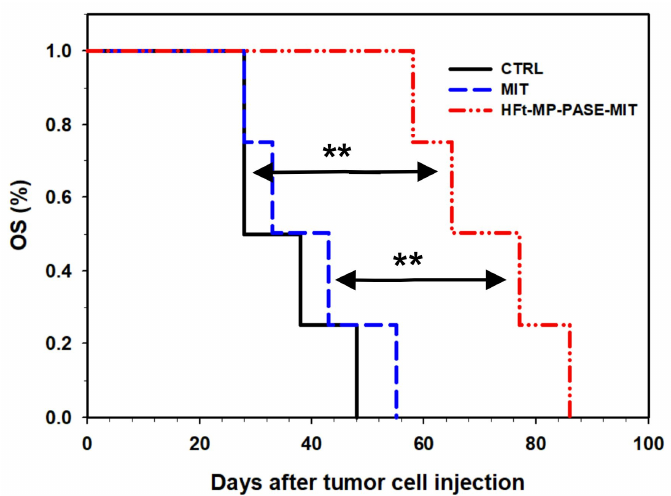
Figure 4. Kaplan-Meier survival plot. Mice with established s.c. tumor of PaCa44 cells were treated twice a week for three consecutive weeks with HFt-MP-PASE-MIT, MIT or saline (CTRL, control). ( n = 4) ** p < 0.01.